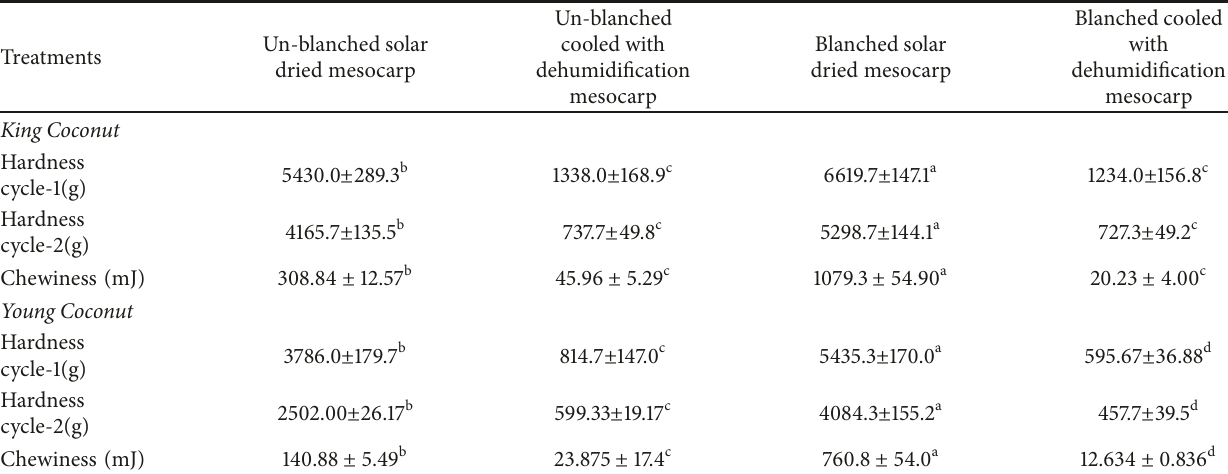
Table 2: The hardness and chewiness values for King and Young coconut mesocarp under different treatments.